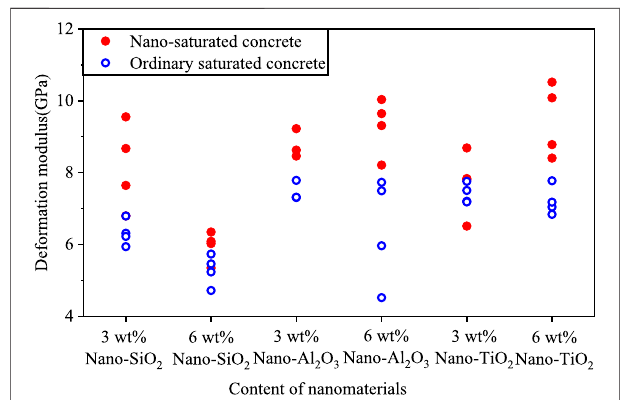
FIGURE 8 | Comparison of deformation modulus of various types of